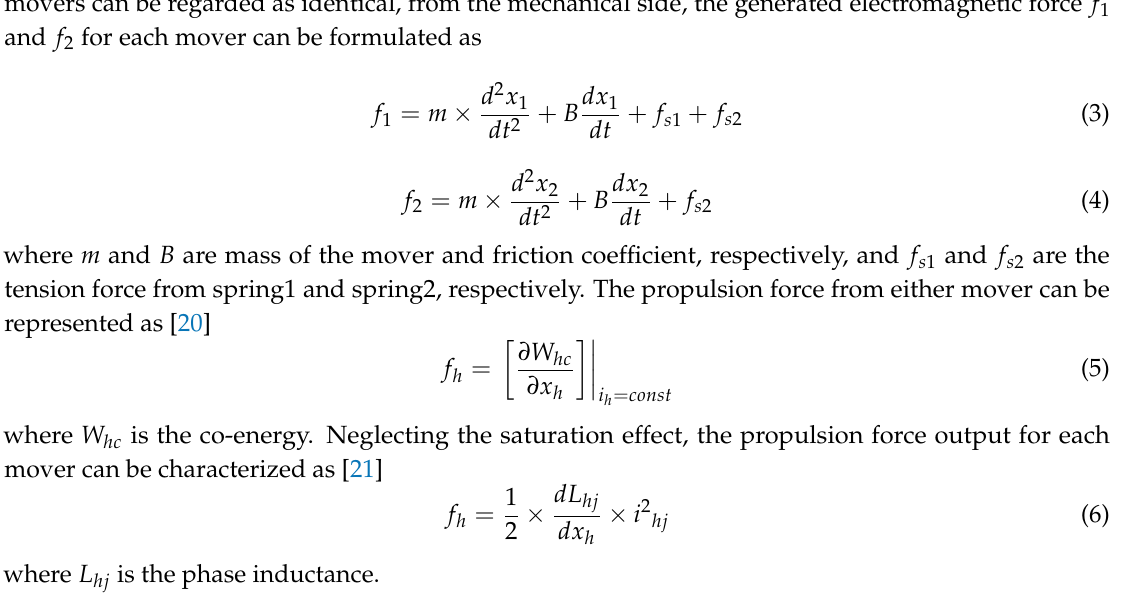
Table 1. Major Specifications of the dual-mover